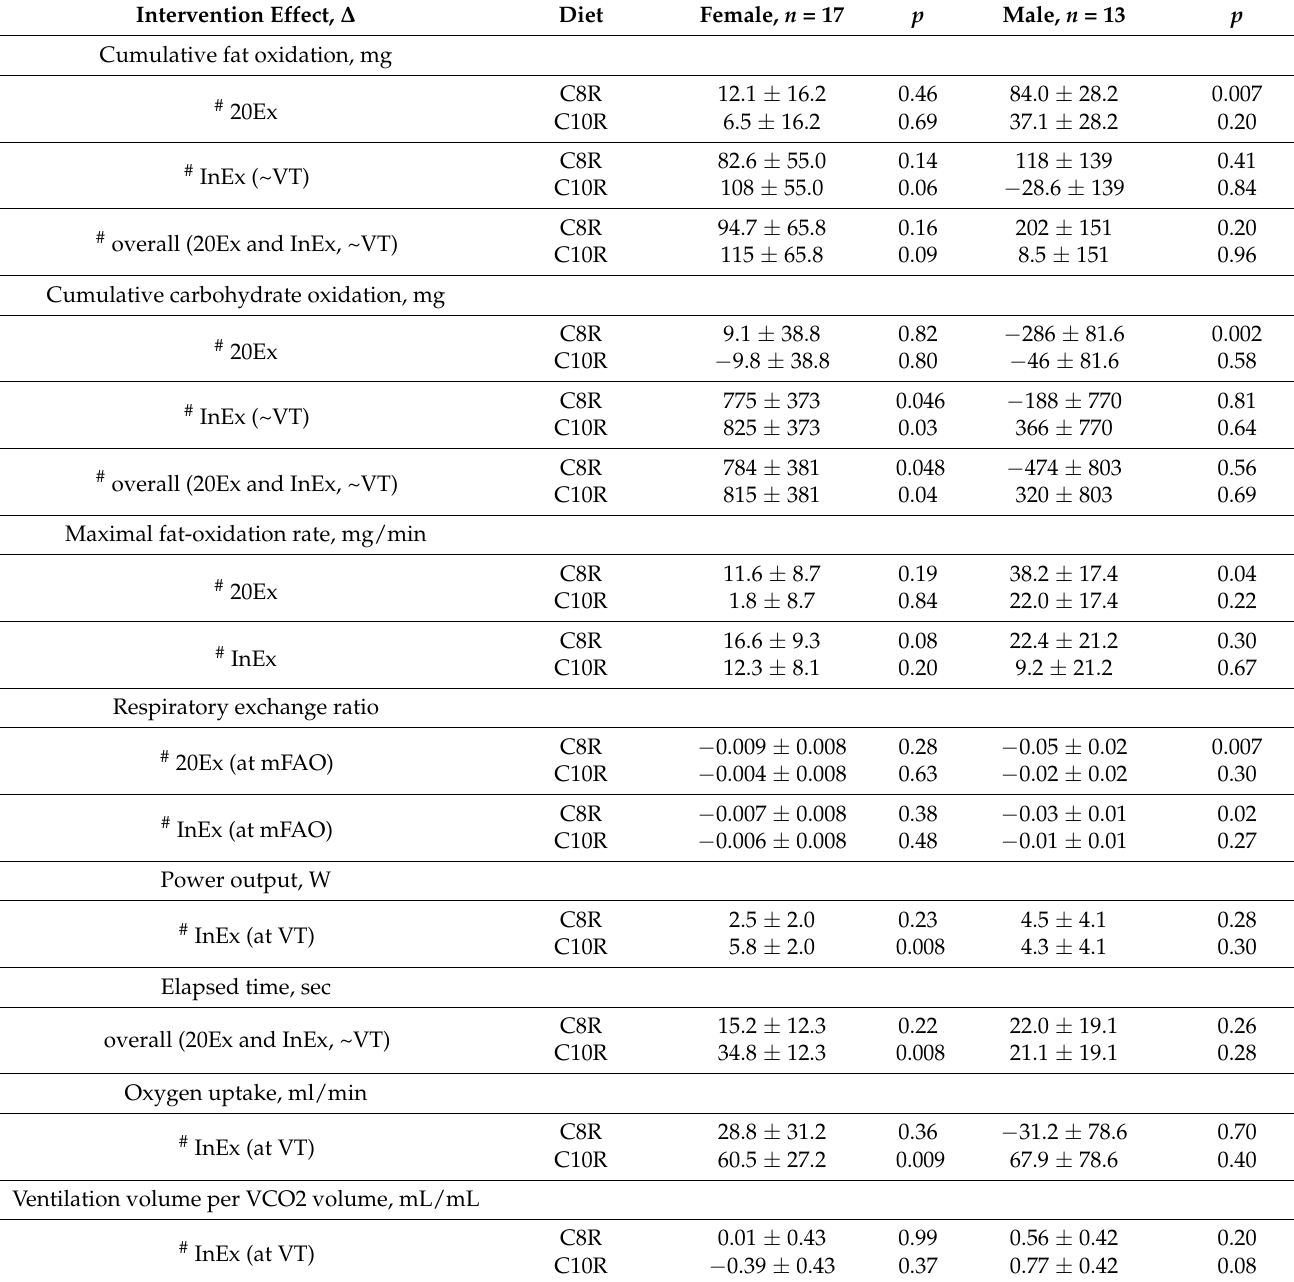
Table 4. Cumulative values of fat and carbohydrate oxidation, maximal fat oxidation rate, respiratory exchange ratio, power output, oxygen uptake, and ventilation volume per VCO2 volume during the experimental trial after ingestion of a control or C8R or C10R diet for two weeks, in the present